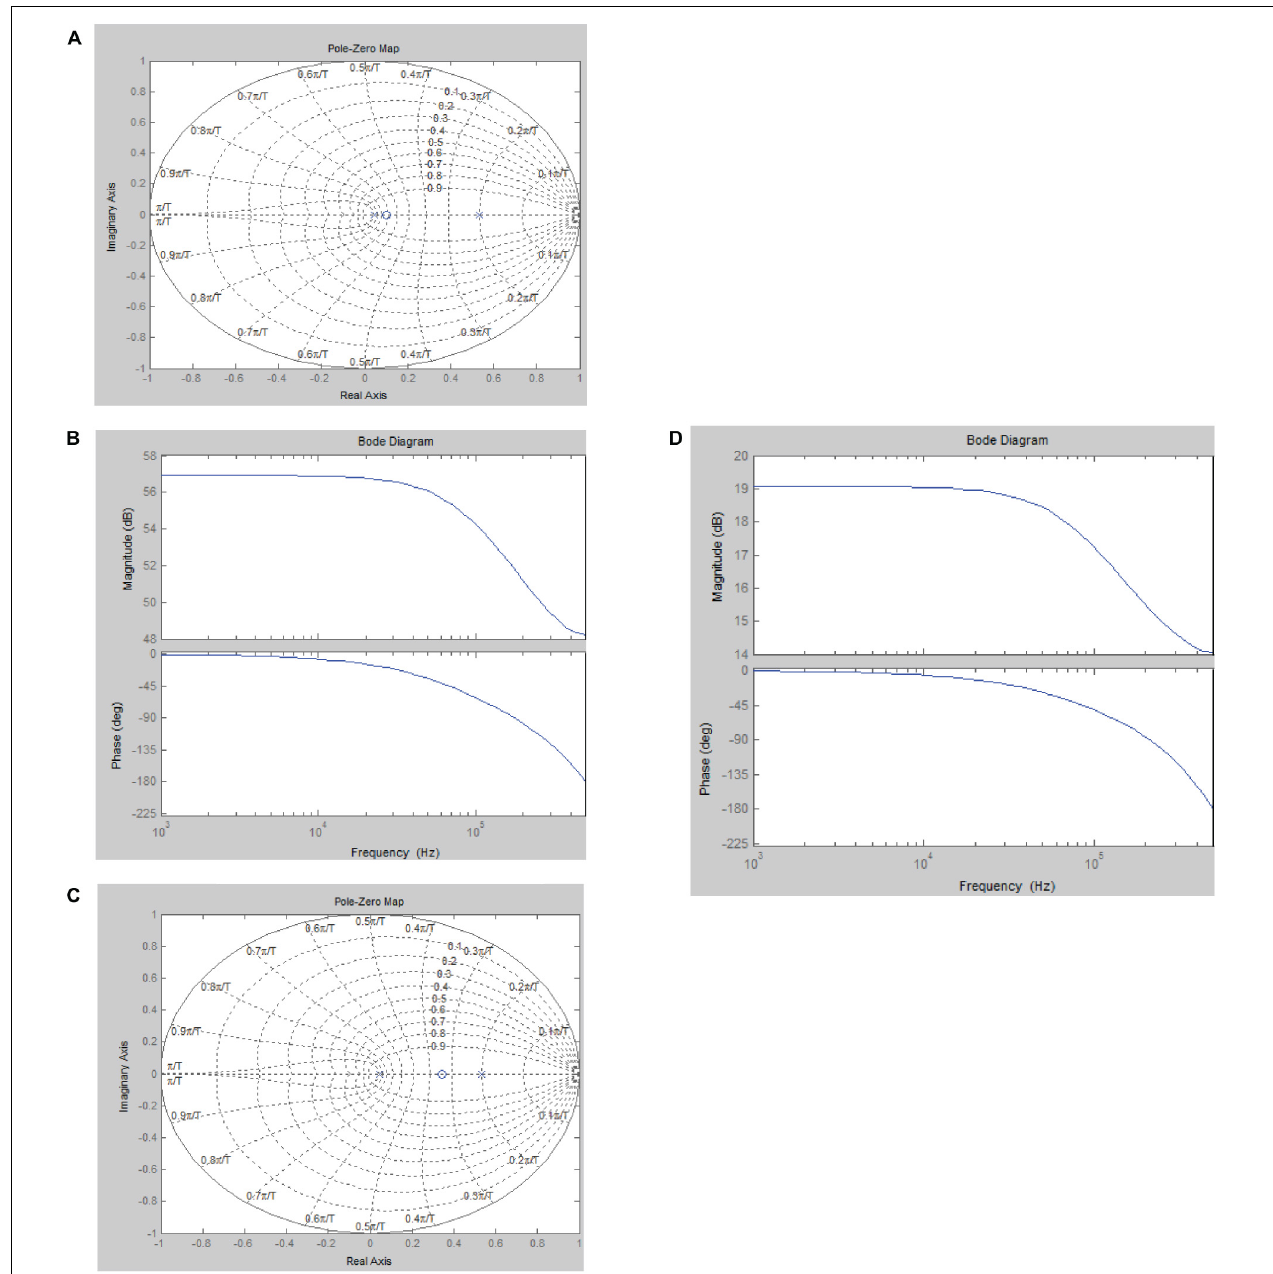
FIGURE 7 | Small signal model simulation diagram. (A) Zero pole diagram of output impedance. (B) Bode diagram of output impedance. (C) Zero pole diagram of voltage gain. (D) Bode diagram of voltage